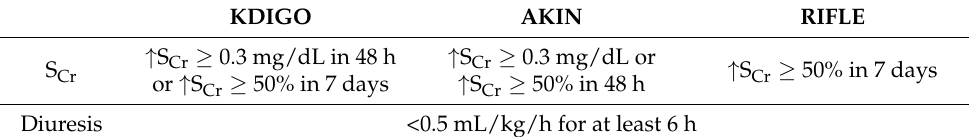
Table 1. AKI diagnostic criteria according to KDIGO, AKIN and RIFLE